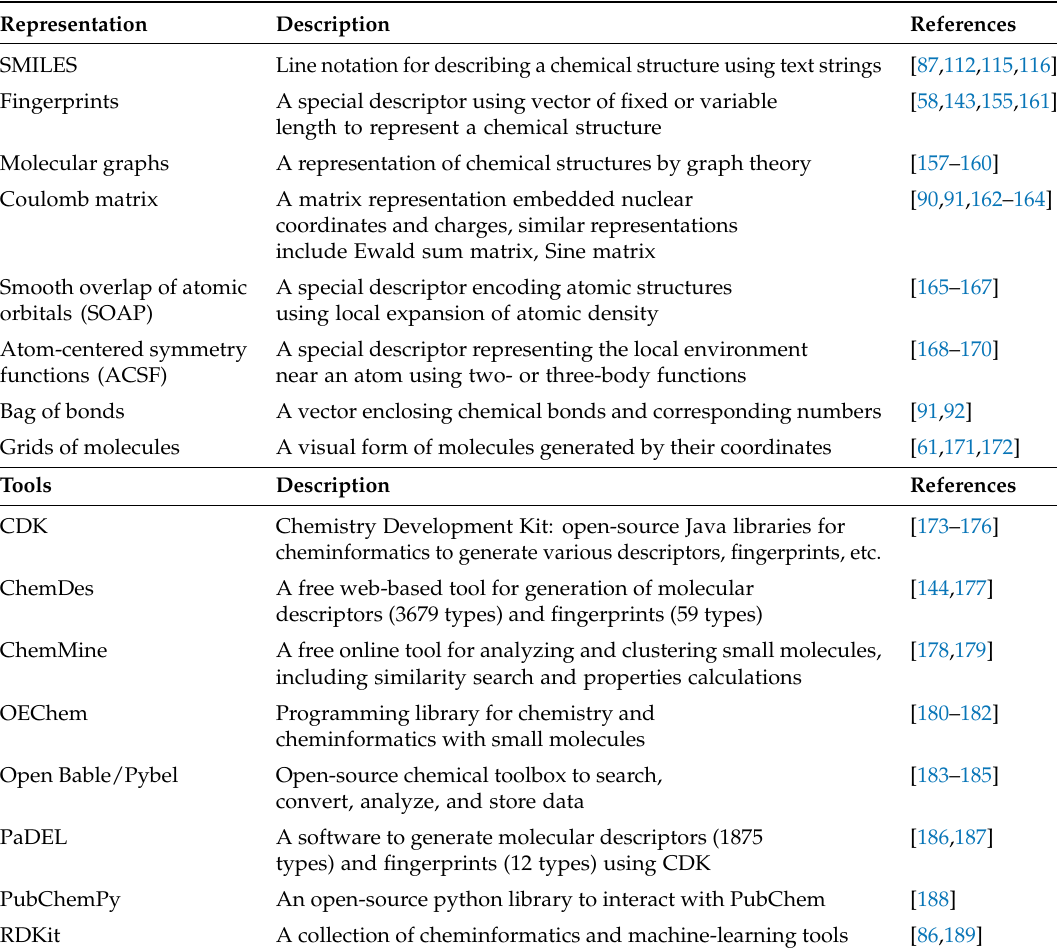
Table 3. Common feature representations of organic molecules and tools for feature